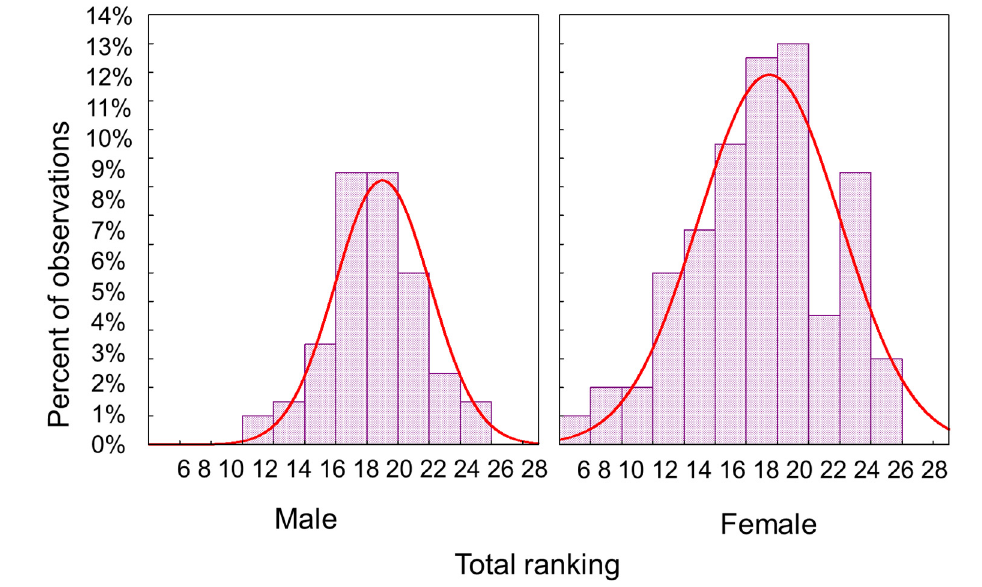
Figure 10. Histogram of total ranking categorized by gender (normal fitted).